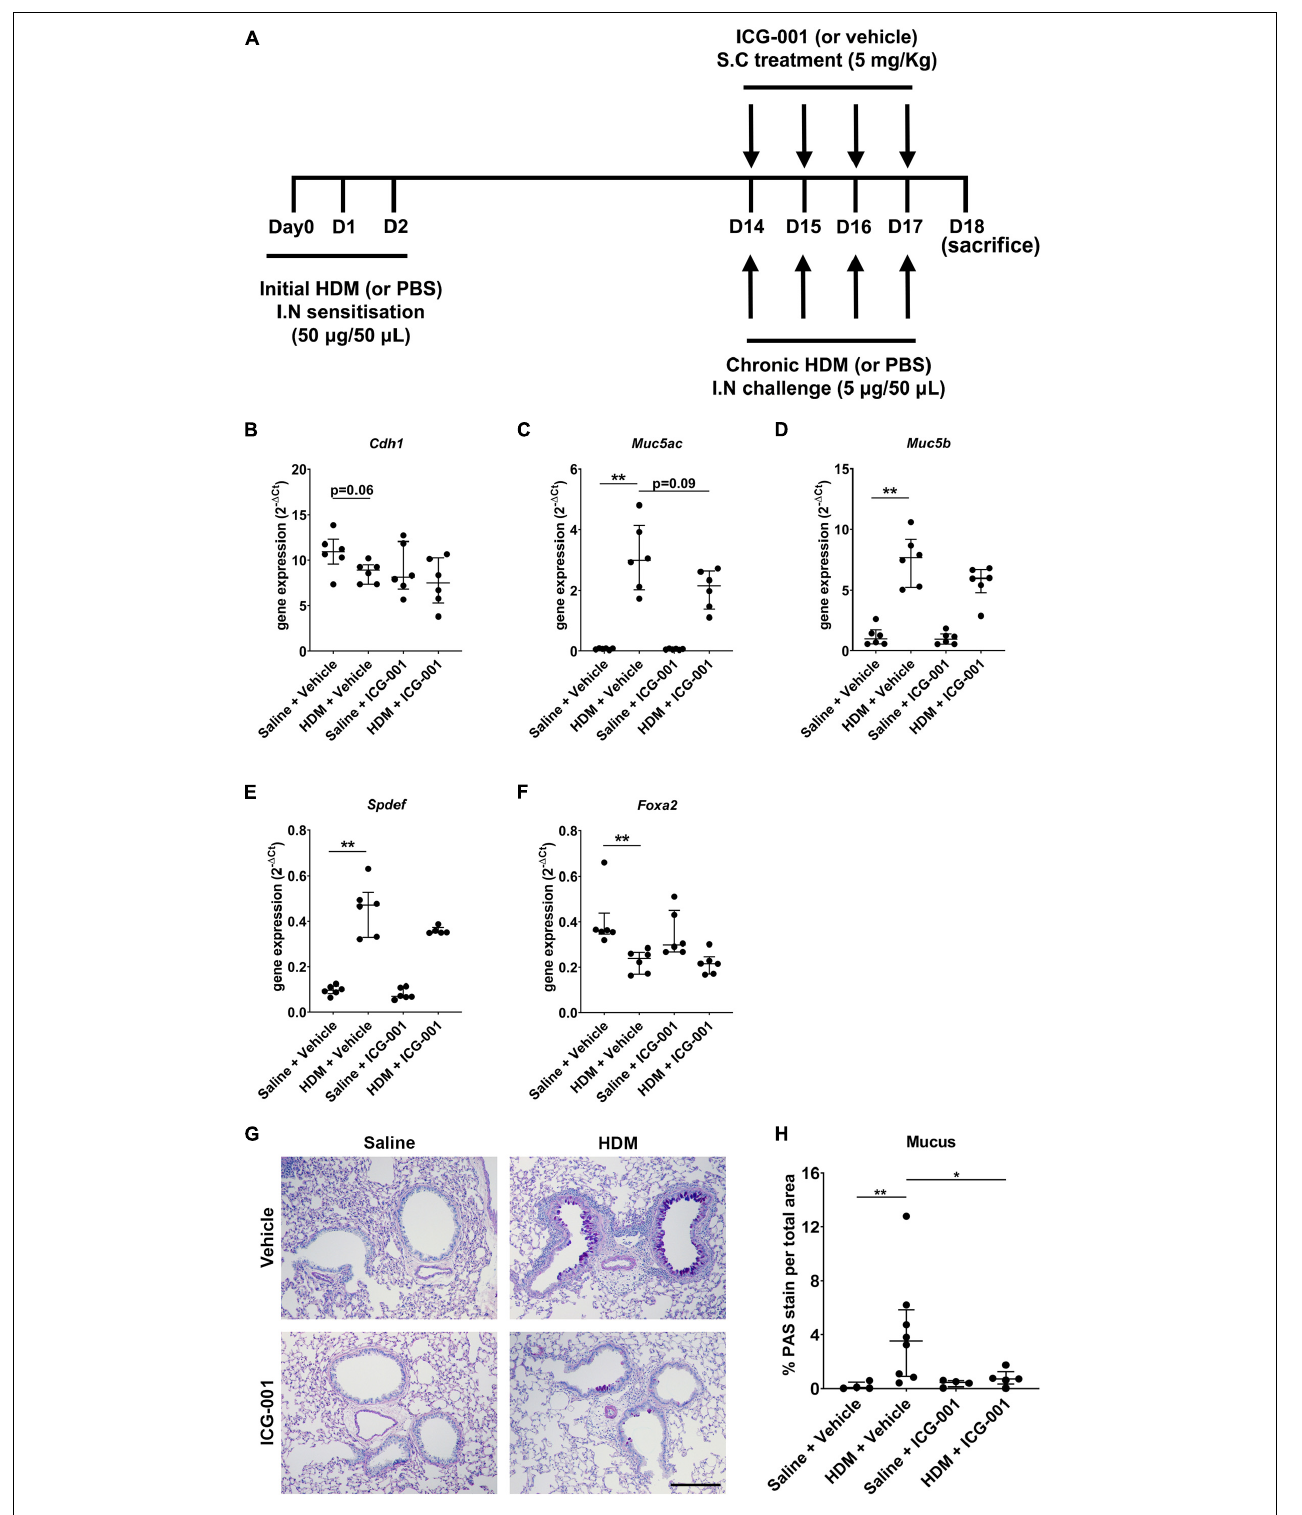
FIGURE 2 | ICG-001 decreases HDM-induced goblet cell metaplasia. (A) HDM-induced allergic airway disease model in mice treated with the ICG-001 inhibitor. (B–F) Gene expression of Cdh1 ( n = 6), Muc5ac ( n = 6), Muc5b ( n = 6), Spdef ( n = 5–6) and Foxa2 ( n = 6) normalized to Hprt ( n = 6) (G) Alcian Blue (AB)/Periodic acid–Schiff (PAS) staining of lung sections from mice for mucus ( n = 4–8), scale = 100 µ m. (H) Semi-quantification of AB/PAS staining for mucus using color deconvolution ( n = 4–8). Data is presented as median ± IQR; * p < 0.05, ** p < 0.01, Mann–Whitney U test.